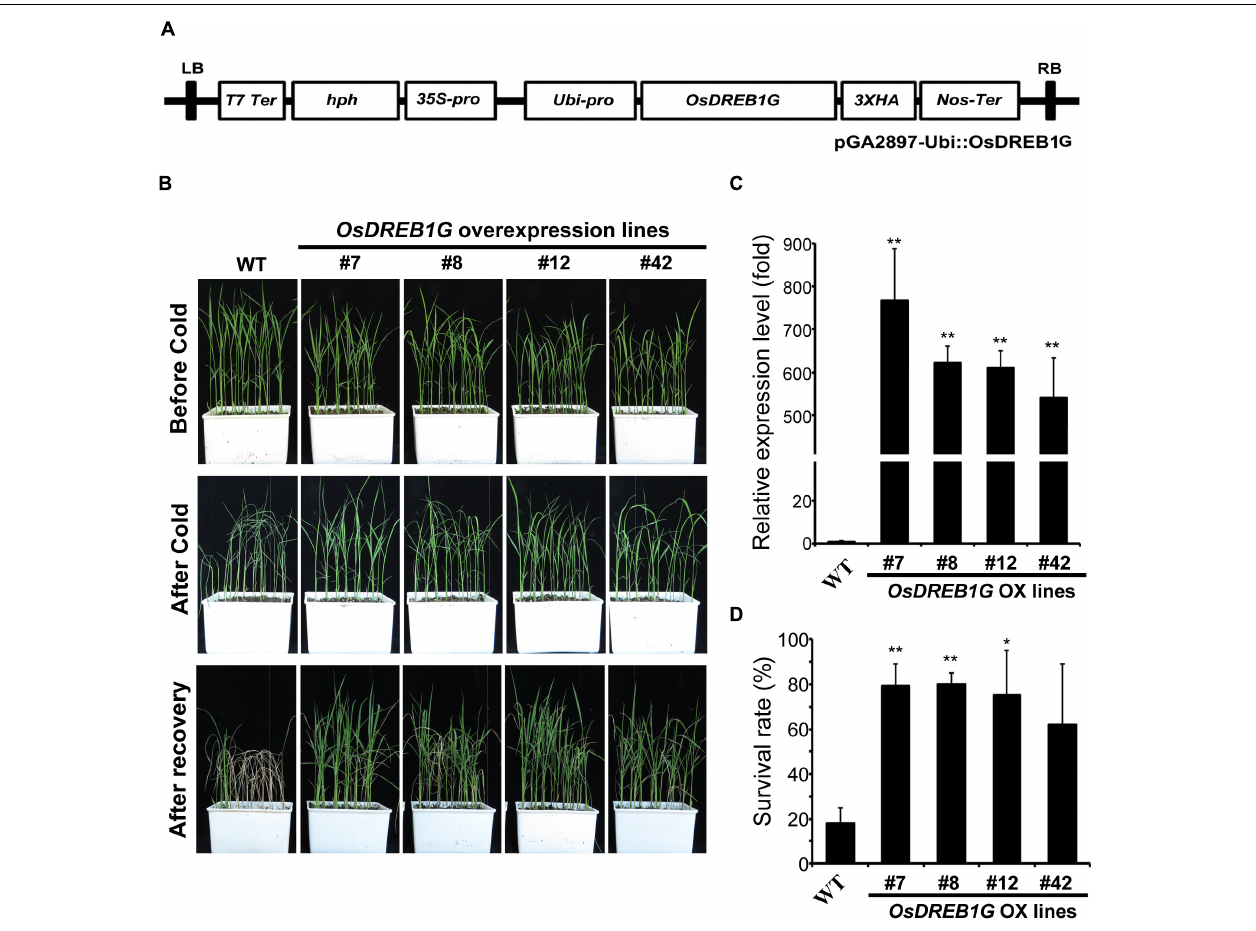
FIGURE 3 | OsDREB1G -overexpressing transgenic rice shows enhanced cold stress tolerance. (A) Vector map for overexpress OsDREB1G and transform into rice. (B) Two-week-old T2 transgenic rice plants were subjected to cold stress (4 ◦ C) for 3 days and then recovered for 7 days in a growth chamber maintained at 28 ◦ C and 60% relative humidity under long-day conditions (16 h light/8 h dark cycle). (C) Gene expression analysis of OsDREB1G in four independent T2 OsDREB1G overexpression transgenic rice lines by RT-qPCR. RNA was isolated from two-week-old seedlings grown in 1/2 MS media. (D) Survival rates of transgenic rice plants overexpressing OsDREB1G under cold-stress conditions. Error bars indicate standard errors. The experiments were repeated three times. ∗ means P < 0.05, ∗∗ means P <